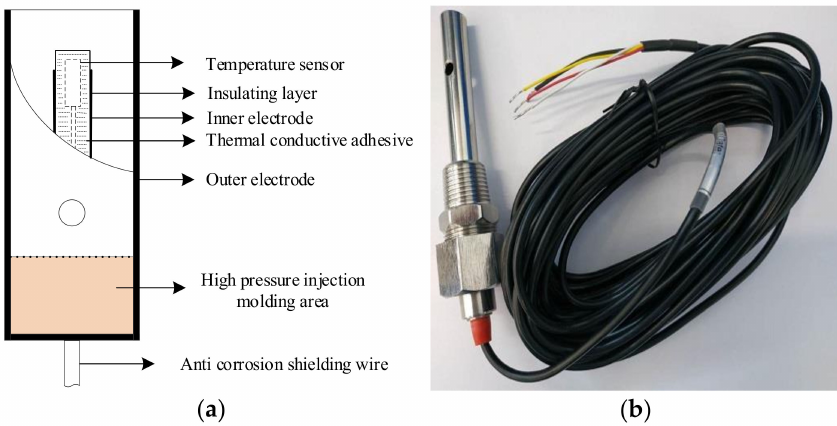
Figure 12. ( a ) Internal structure and ( b ) physical image of the sensor.